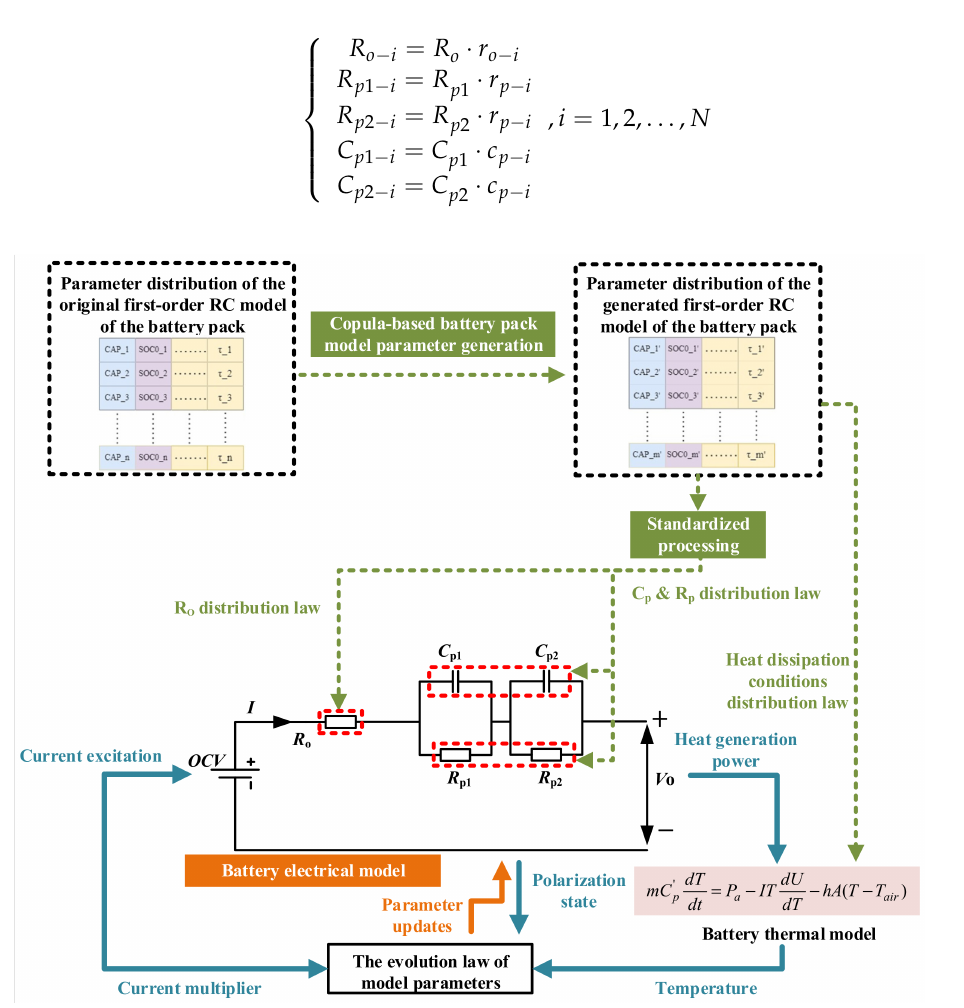
Figure 2. Schematic diagram of virtual battery pack modeling. In the simulation calculation of the battery pack based on the virtual battery, the whole calculation process is slow if the model is called repeatedly for each battery, which is obviously unreasonable. Therefore, multiple battery cell models are matrixed in a single computational process for the virtual battery pack. The polarization voltage and terminal voltage are calculated with Equations (6) and (7). The matrixed processing of the battery model improves the computational efficiency of the virtual battery model. Subsequently, the dynamic voltage response of the virtual battery is